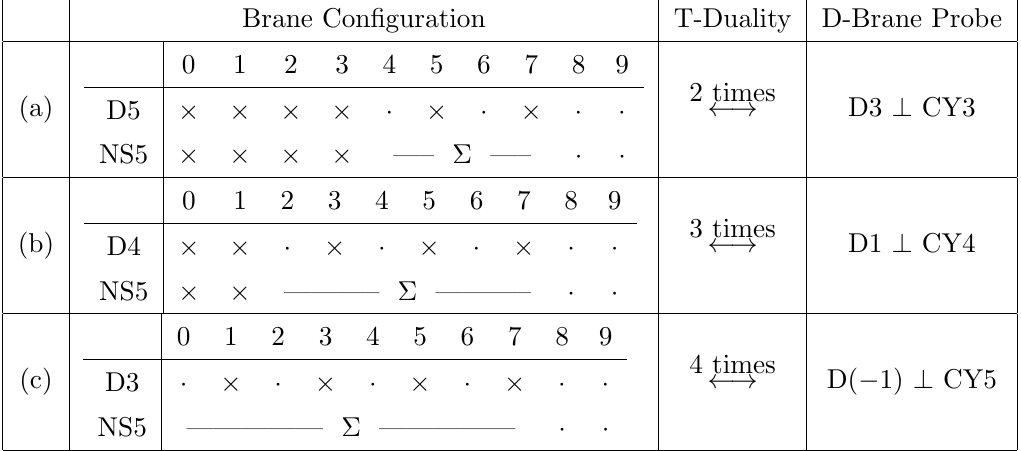
Table 3 . The various brane con(cid:12)gurations for supersymmetric gauge theories arising on D-brane probes at toric Calabi-Yau singularities. (a) Brane tilings give rise to 4 d = 1 supersymmetric N gauge theories as worldvolume theories D3-branes at toric Calabi-Yau threefold singularities, (b) brane brick models give rise to 2 d = (0 ; 2) theories as worldvolume theories of D1-branes at toric N Calabi-Yau fourfold singularities, and (c) brane hyper-brick models give rise to 0 d = 1 N